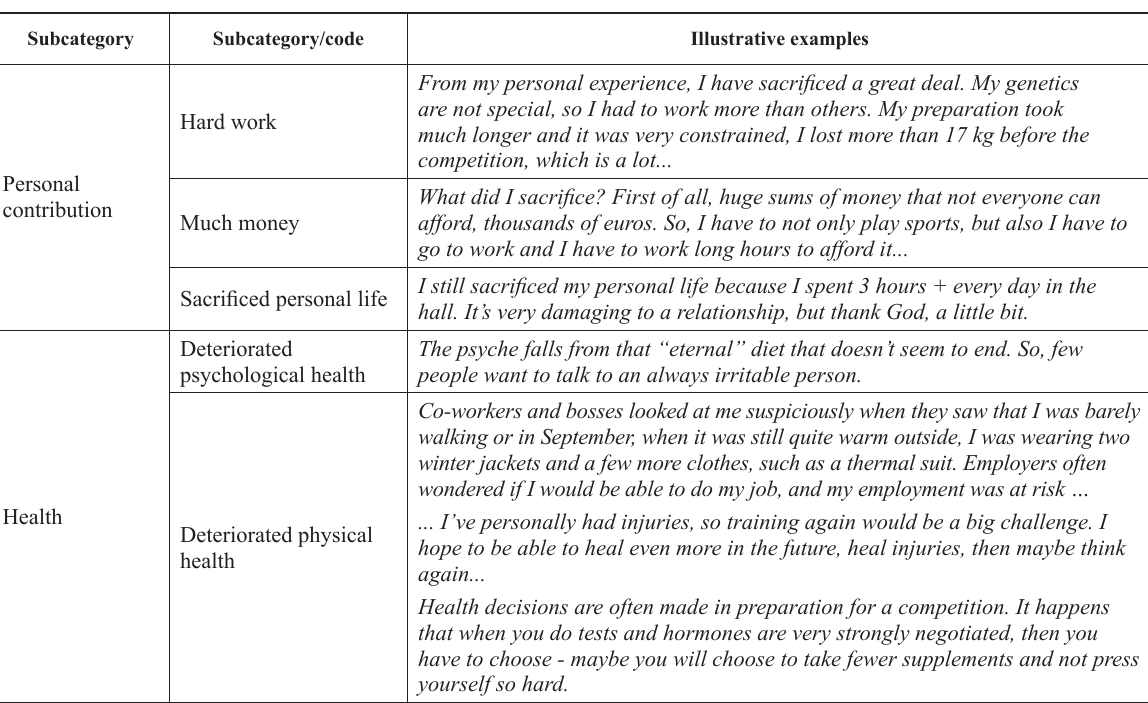
Table 3. Category: The costs of bodybuilding